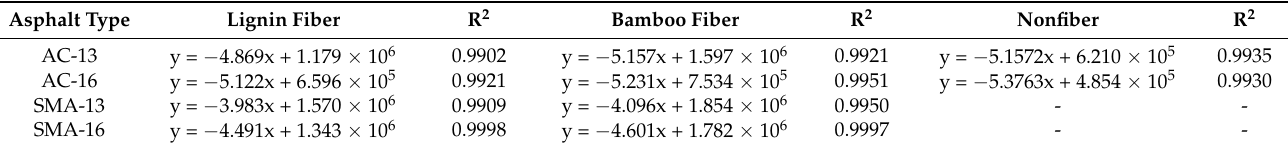
Figure 11. Relationship between fatigue life and stress level of asphalt mixture with different fibers. Table 8. Regression equation of fatigue life of asphalt mixture with different